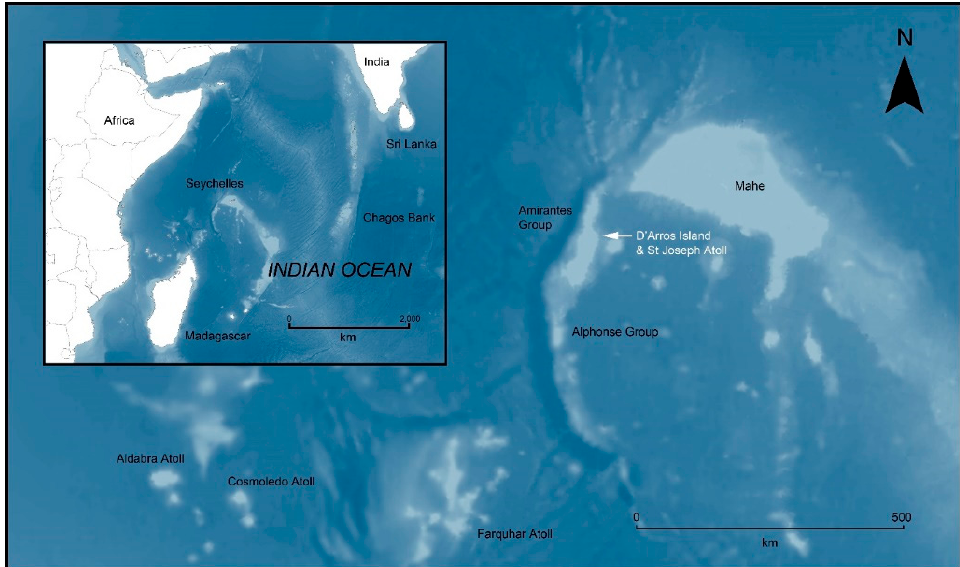
Figure 1. Map displaying the D’Arros island and St Joseph atoll site, situated on the Amirantes bank, Republic of Seychelles. Inset displays broader geographic reference in Western Indian Ocean. Map created in ArcGIS 10.5 using GEBCO_08 bathymetry data: GEBCO Compilation Group (2020) GEBCO 2020 Grid (doi:10.5285/a29c5465-b138-234d-e053-6c86abc040b9).